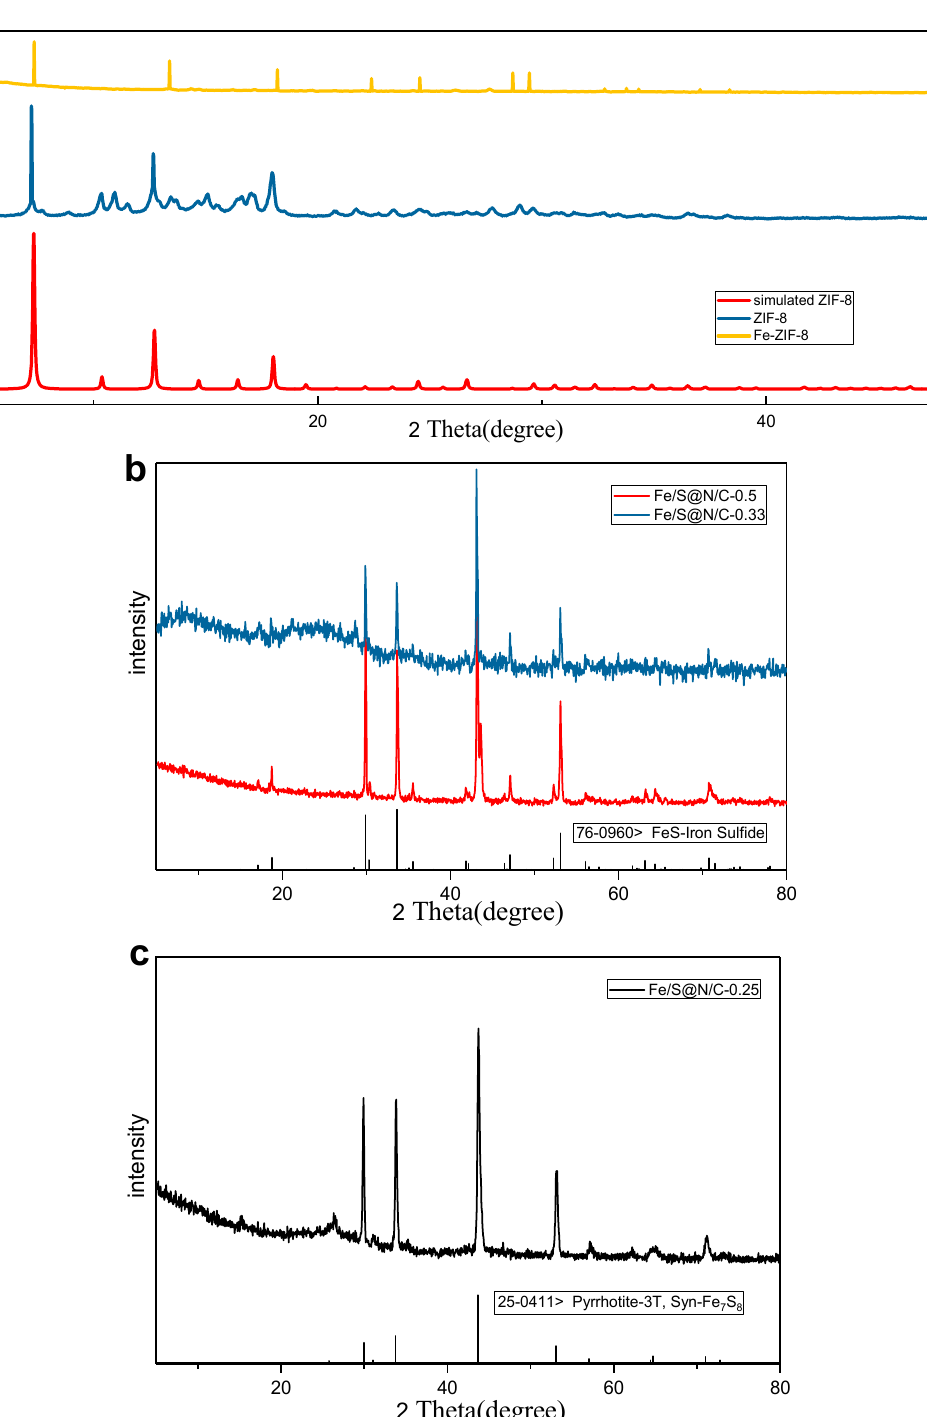
Figure 6. ( a ) XRD patterns of precursor of Fe / S@N / C-0.5. ( b ) XRD patterns of Fe / S@N / C-0.5 and Fe / S@N / C-0.33. ( c ) XRD patterns of Fe / S@N /